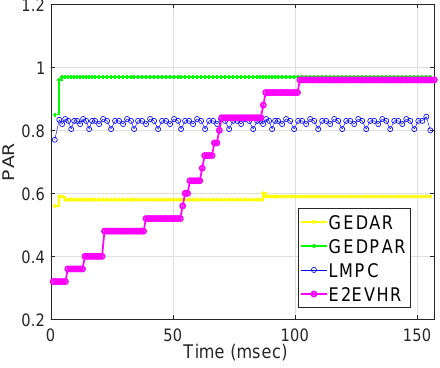
Figure 12. Packets received at sink.